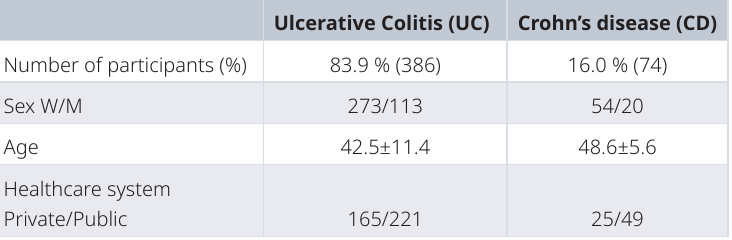
Table 1. General characteristics of the study